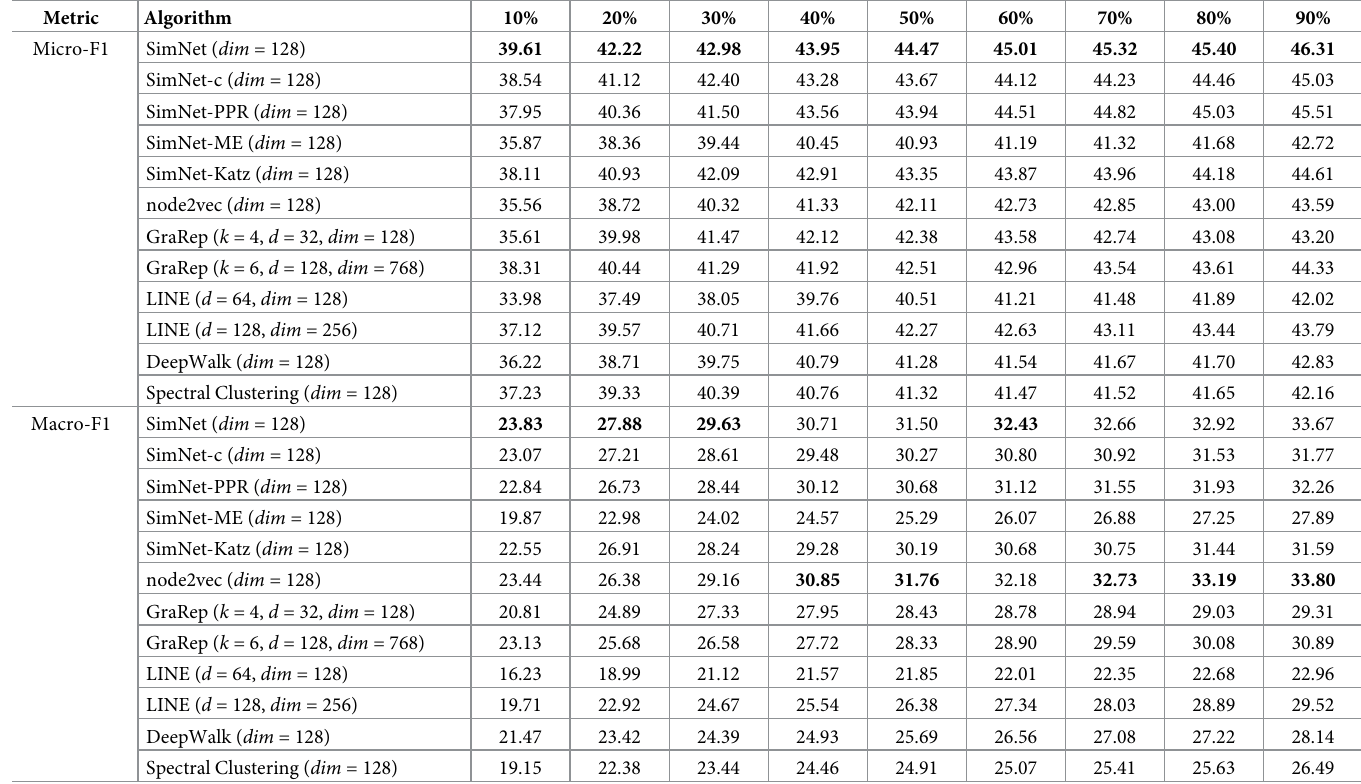
Table 2. Results on